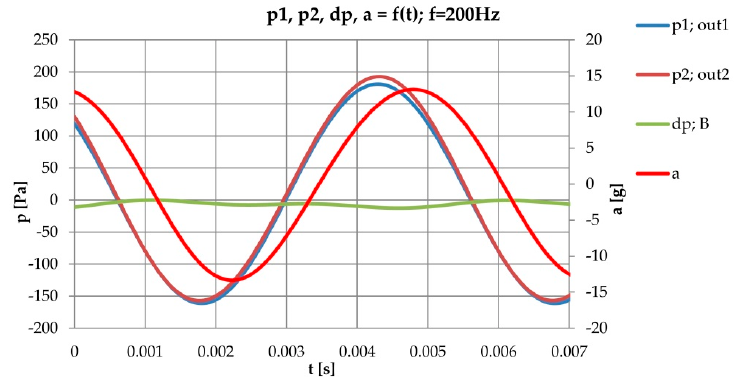
Figure 14. Response of the complex sensor to a harmonic signal with f = 200 Hz, p1—signal from the measuring sensor, p2—signal from the compensation sensor, dp—difference between p1-p2, and a—the input.